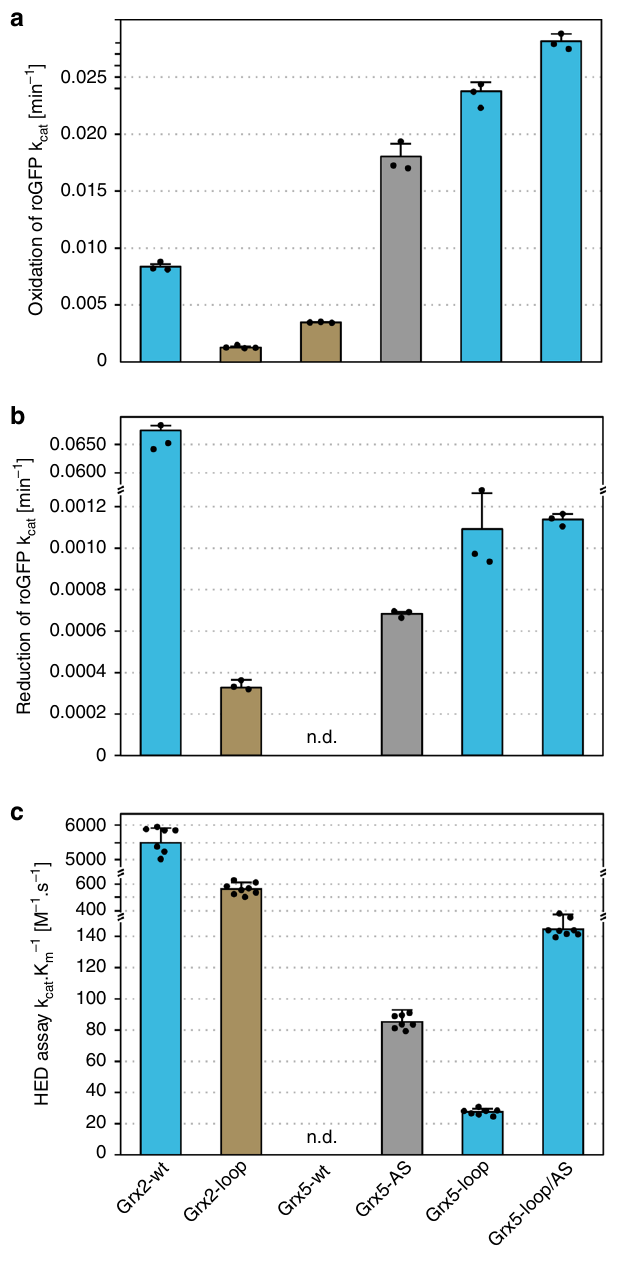
Fig. 3 Comparison of the catalytic activities of the wild-type and engineered Grxs. a Catalytic activity ( k cat ) of the Grxs in the oxidation of roGFP2. b catalytic activity ( k cat ) of the Grxs in the reduction of roGFP2; k cat here was de fi ned as the speci fi c initial rate of roGFP oxidation and reduction, respectively, at 1 µ mol l − 1 substrate concentration. c Catalytic ef fi ciency ( k cat · K m − 1 ) of the Grxs in the HED assay. All data are shown as mean ± sd. The roGFP2 assays were all performed at four different Grx concentrations with three replicates each, the HED assay data represent the mean of n = 7 – 8. n.d. not detected. Blue bars represents the proteins with the CxxC/S-type loop, brown bars proteins with the CGFS-type loop, the gray bar Grx5 with the CSYC active site of Grx2. Source data are provided as a Source data fi